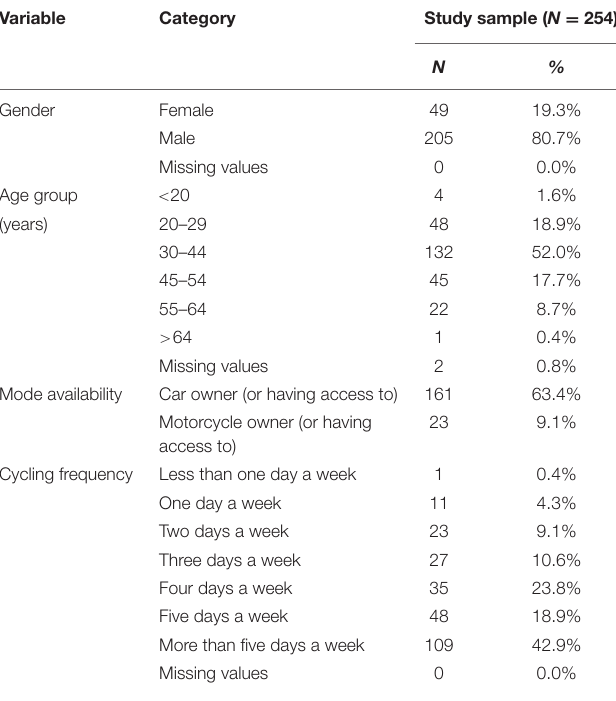
TABLE 1 | Descriptive statistics of the survey